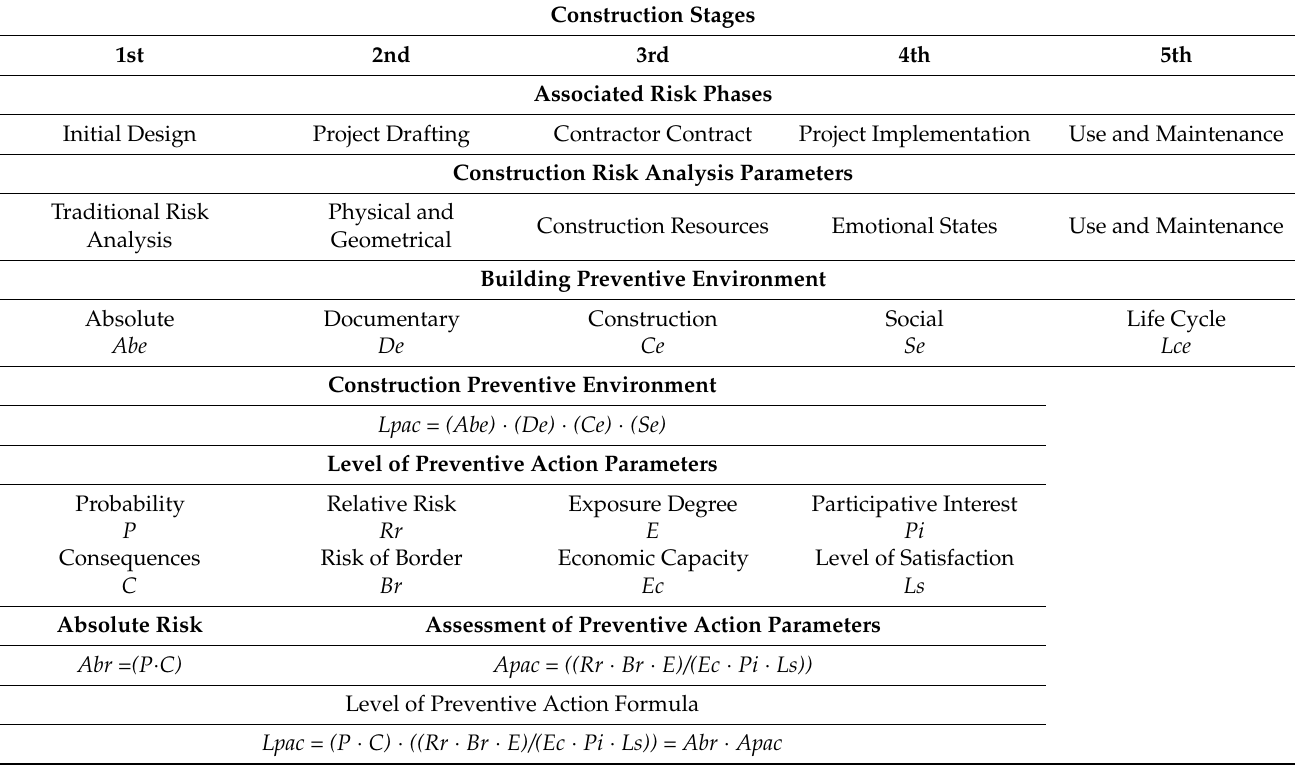
Table 1. Level of Preventive Action. Theoretical–Mathematical